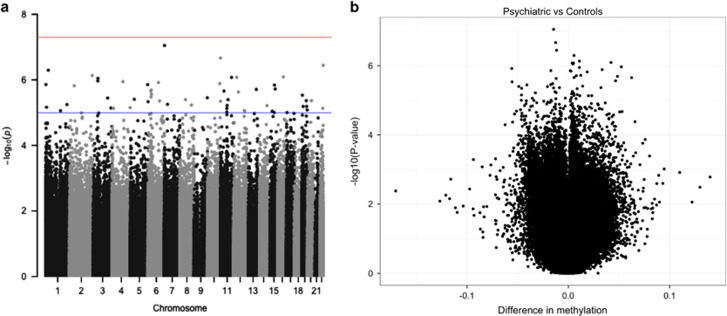
Overview of signals and corresponding effect sizes for results obtained from EWAS of 22q11.2DS individuals with psychiatric phenotype versus controls. Each dot represents one probe used in the EWAS analysis. (a) Manhattan plot depicting significance levels for all probes included in the primary analysis (blue line marks −log10(1e−05), red line marks −log10(5e−08) significance level); (b) volcano plot depicting effect sizes compared with the significance levels of all probes included in the primary analysis. DS, deletion syndrome; EWAS, Epigenome-Wide Association Study.